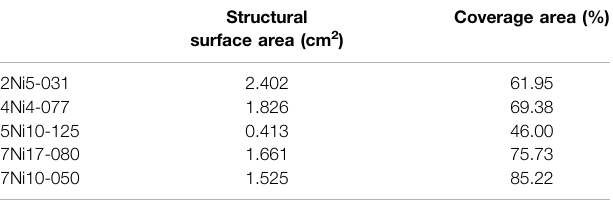
Frontiers in Chemistry |